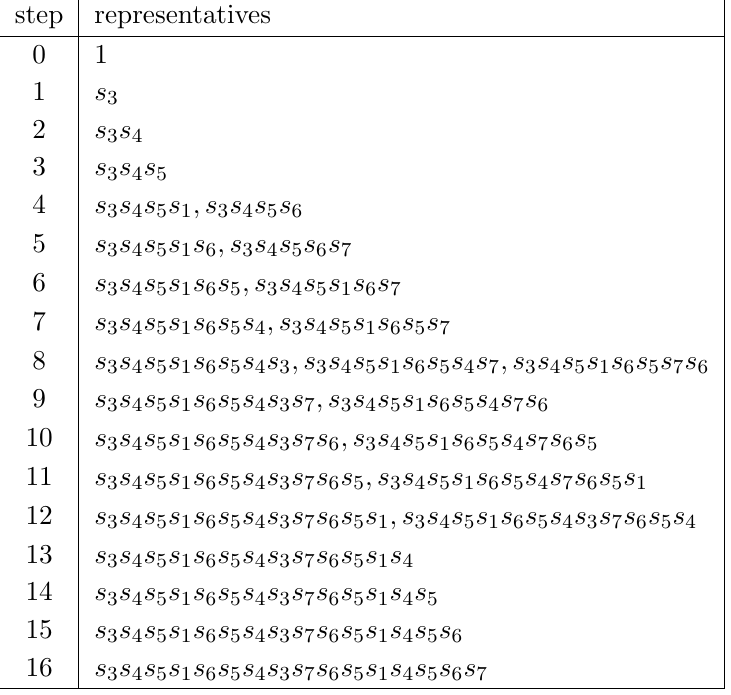
Table 6 . The 27 cosets of the D 5 Weyl group (generated by s 1 ; s 4 ; s 5 ; s 6 ; s 7 ) in the E 6 Weyl group (generated by s 1 ; s 3 ; s 4 ; s 5 ; s 6 ; s 7